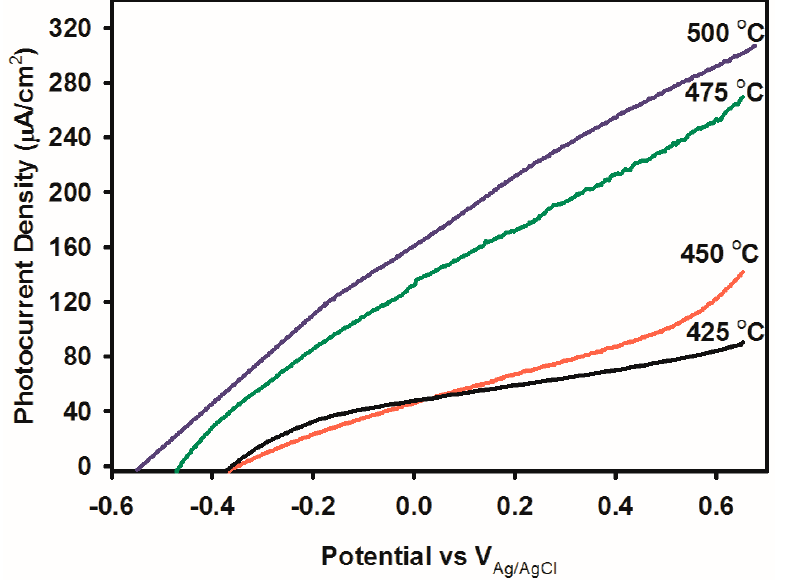
Figure 5. Photocurrent-voltage plots showing the deposition temperature dependence of photocurrent of Bi 2 WO 6 electrodes deposited by AACVD.